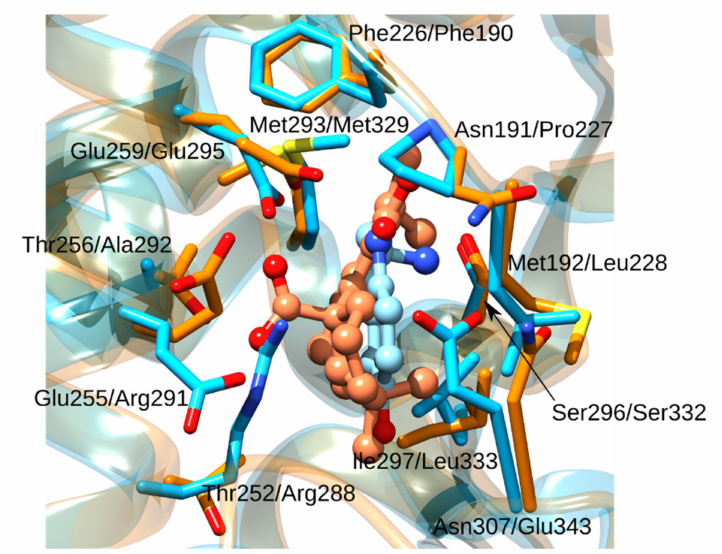
Figure 6. The Ω -pocket superimposition between PPAR δ (orange cartoon and sticks) and PPAR γ (blue cartoon and sticks). The first amino acid residue numbering corresponds to PPAR δ , and the second to PPAR γ . Serotonin is displayed using blue balls and sticks and the docked carnosic acid using orange balls-and-sticks. We emphasize the difference in amino acid residues Thr252 versus Arg288. Compared to Thr252 in PPAR δ , the large Arg288 in PPAR γ would lead to stearic clashes with carnosic